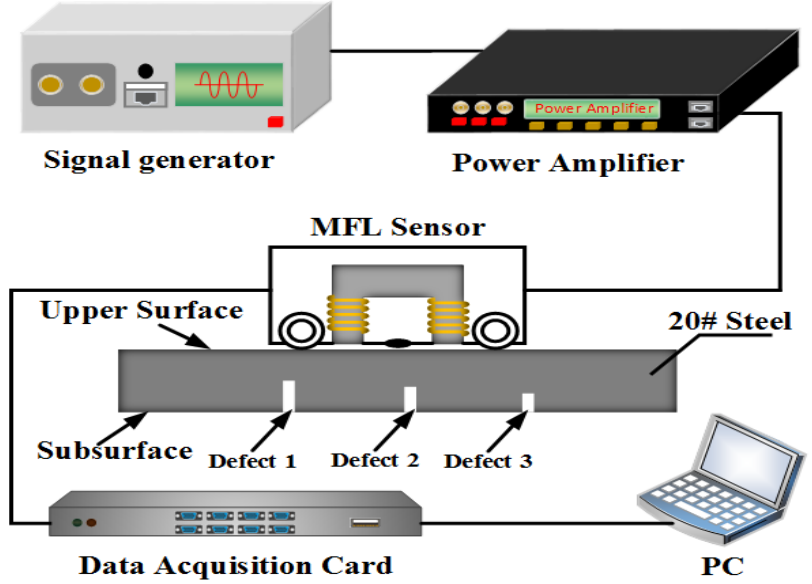
Figure 5. Experimental system of the subsurface defects detection based on the MFL testing.